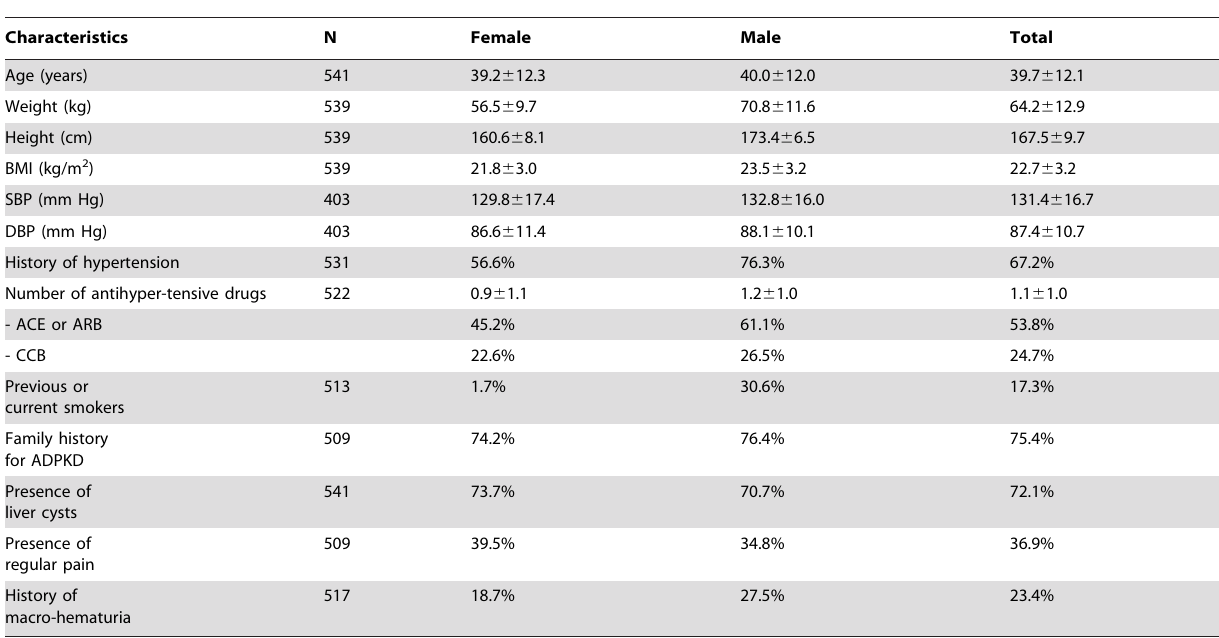
Table 1. Baseline demographics and clinical characteristics of Chinese ADPKD cohort.